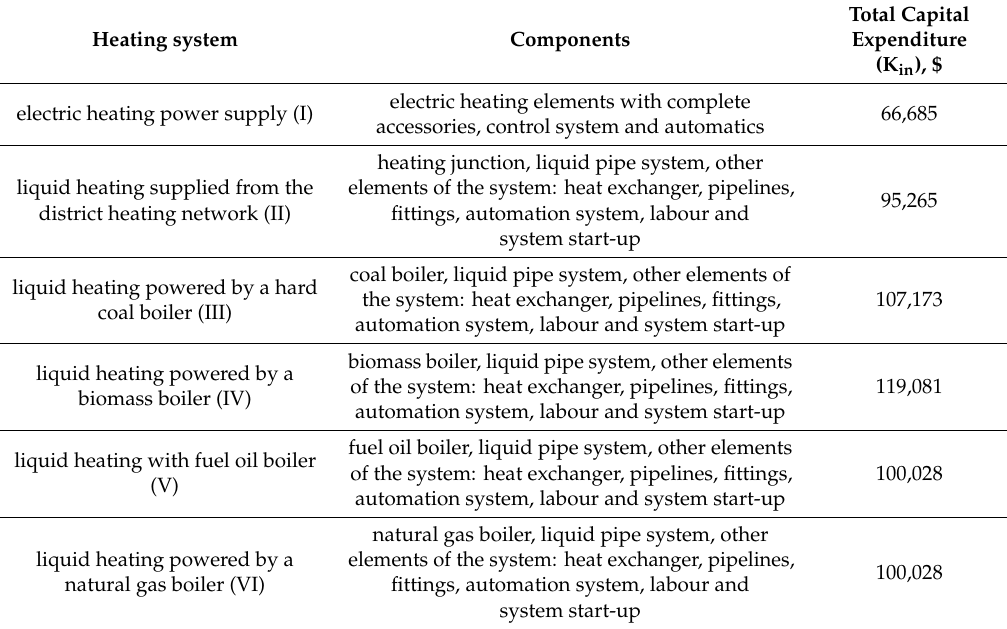
Table 3. Investment expenditure on individual heating